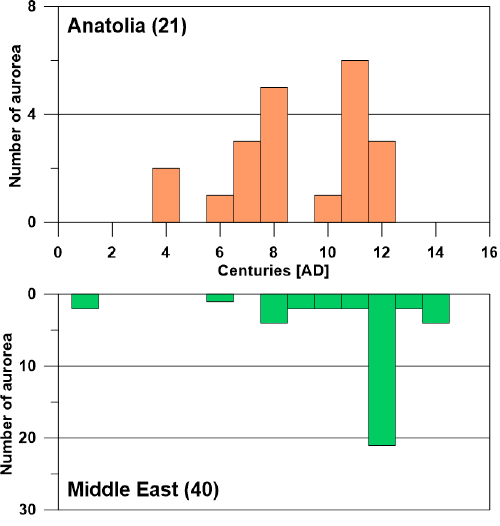
Figure 3. The number of aurora records per century observed in Constantinople, Anatolia, and the Middle